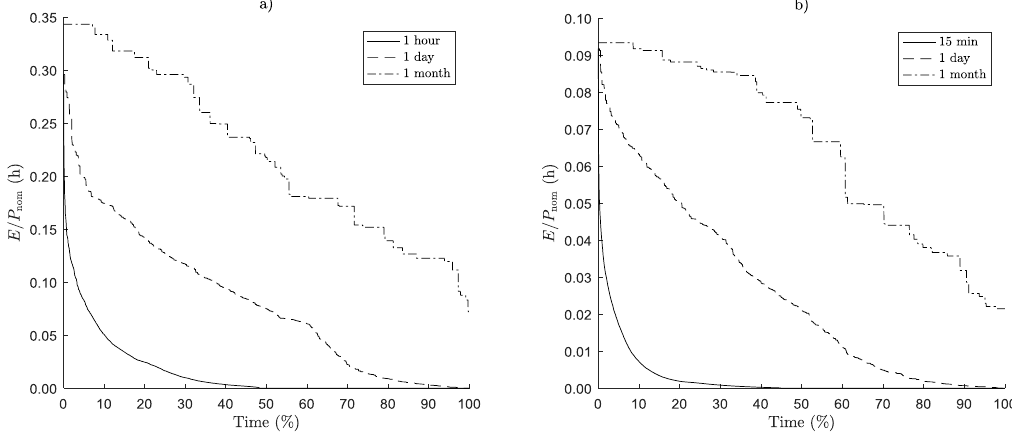
Figure 5. Probability density distributions of the ESS energy capacity requirements using observation periods of the ISP time, one day and on month in 2015 for ( a ) 60 min and ( b ) 15 min ISP times.